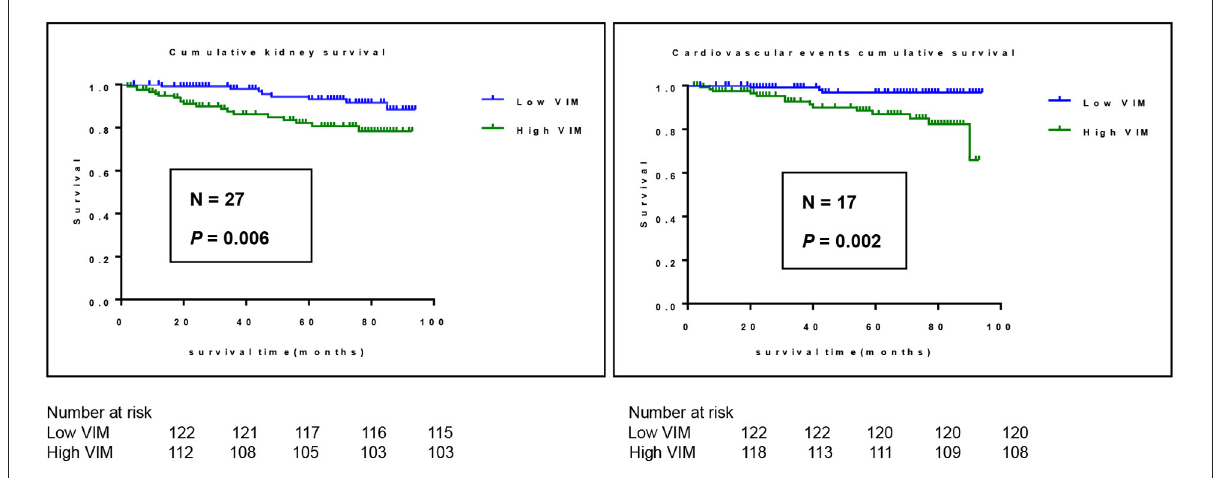
FIGURE3 Kaplan-Meier survival curves for outcome of cardiovascular events and renal progression in participants stratified according to 24h SBP-VIM. Cardiovascular events include all cerebrovascular and cardiovascular events.